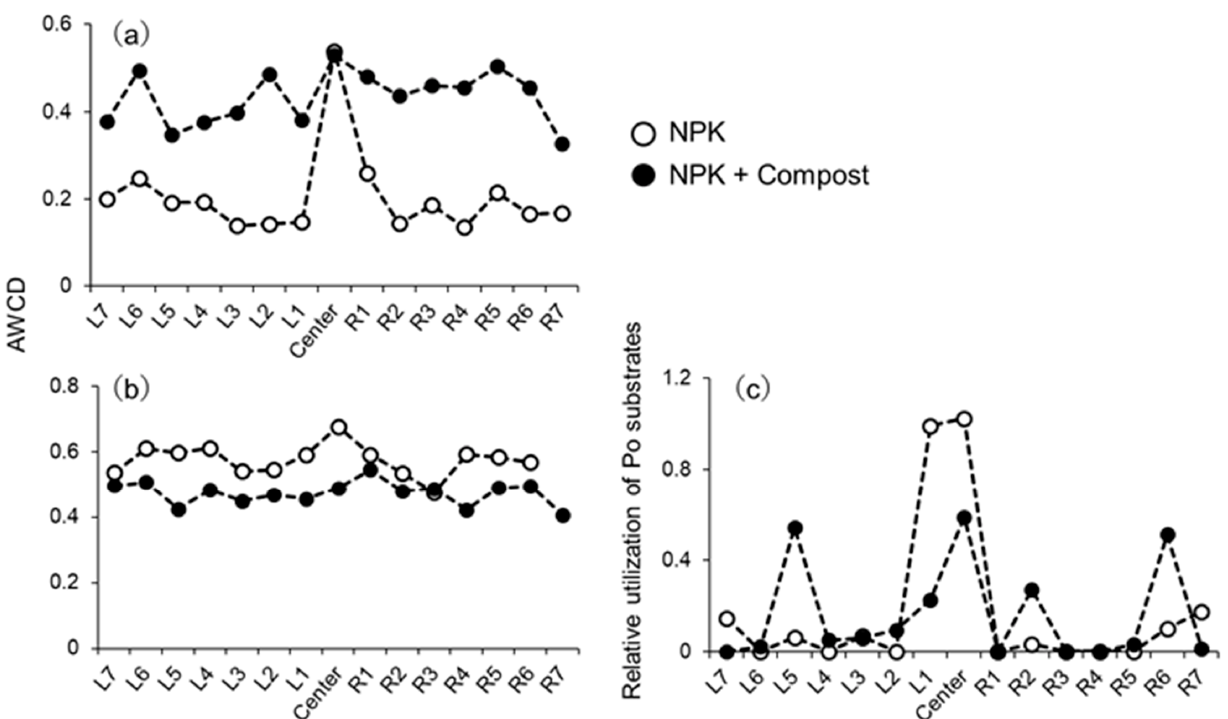
Figure 3. ( a ) Averaged well color development (AWCD) in Biolog ECO plate for the bacterial community, ( b ) AWCD in SFN2 plate for the fungal community, and ( c ) relative utilization of Po substrates by the bacterial community, defined as the ratio of the AWCD of Po substrates to the AWCD of all the substrates contained in the Biolog ECO plate, in soil compartments collected in 1-mm increments from the root compartment where barley was cultivated for 5 weeks in the rhizobox system.